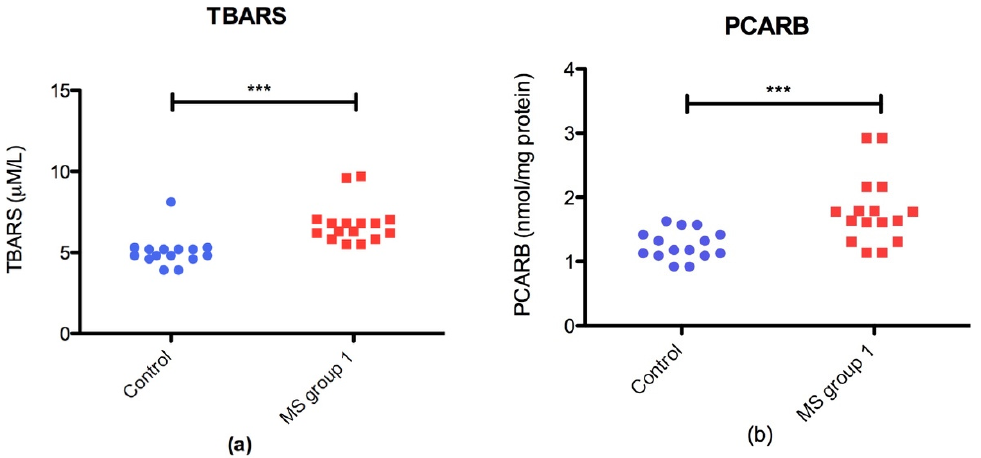
Figure 2. Plasmatic oxidative stress markers in RRMS groupvs control group: ( a ) scatter plot of TBARS levels; ( b ) scatter plot of PCARB (protein carbonyl) level in control group and RRMS group. In contrast, total antioxidant capacity (TAC) was significantly decreased ( p = 0.04 *) in RRMS patients as compared to the healthy control group (Figure